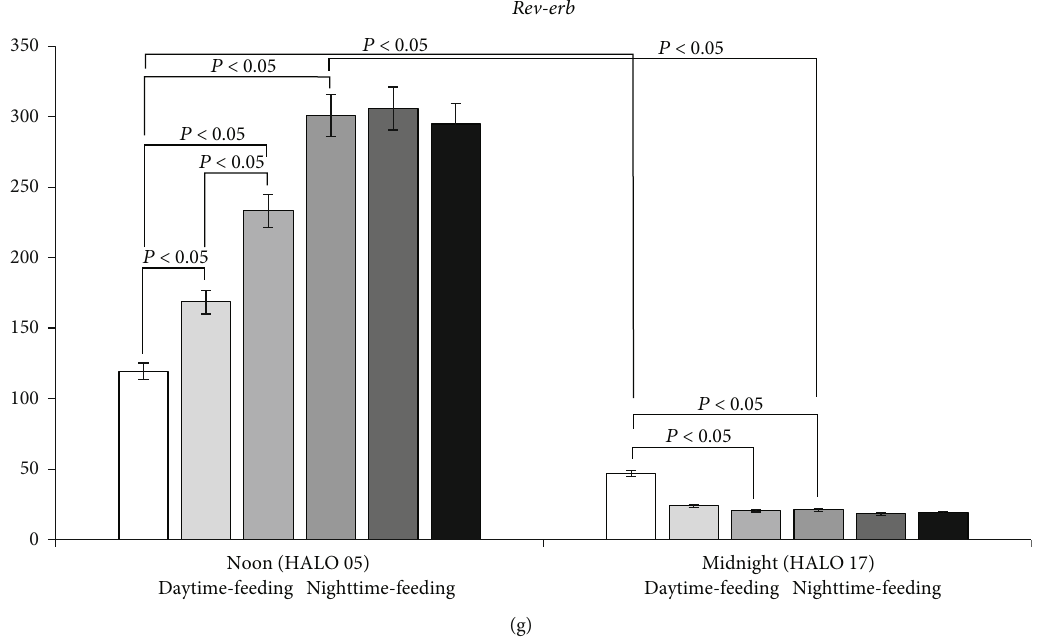
Figure 2: Circadian changes in the mouse clock gene mRNA transcription in the liver tissues. Expression of mRNA: (a) Per 1 ; (b) Per 2 ; (c) Cry1 ; (d) Cry2 ; (e) Clock ; (f) Bmal1 ; and (g) Rev-erb alpha . Signi fi cant di ff erences are shown by horizontal lines ( P < 0 : 05